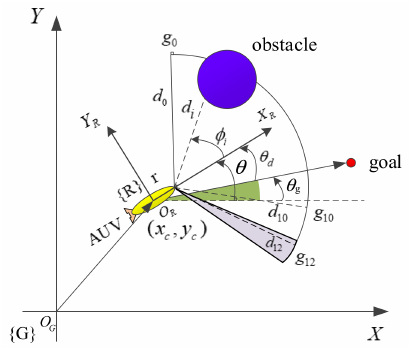
Figure 1. AUV coordinate system and obstacle detection